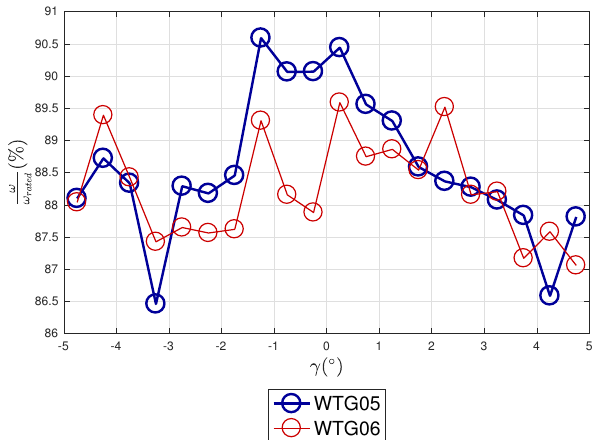
Figure 7. The yaw error–rotor speed curve for WTG05 and a sample reference wind turbine (WTG06): [7, 8] m/s wind speed interval. Data set D aft